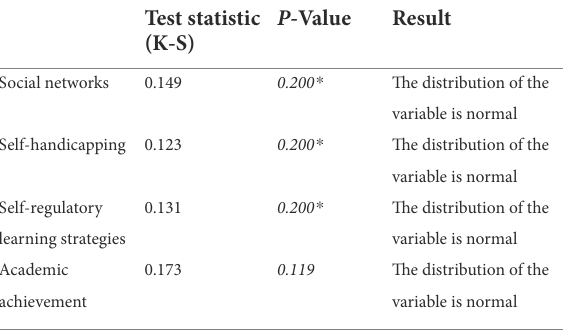
*Significance at the level of 0.05 ( p <